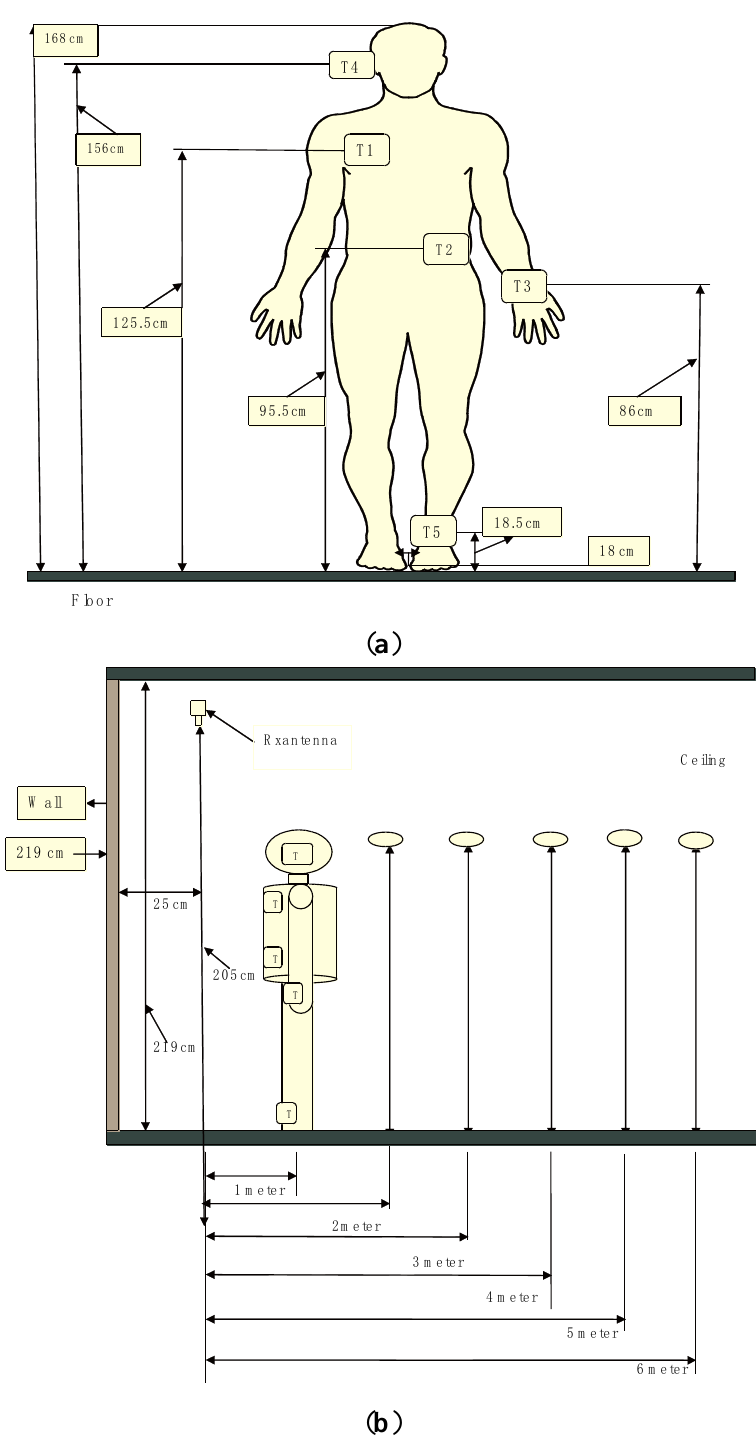
Figure 13. Off-body measurement settings of the dual band PIFA at 1.9 GHz, ( a ) locations of the antenna on the human body, ( b ) measurement scenarios and side view showing receiving antenna and the antenna on the human